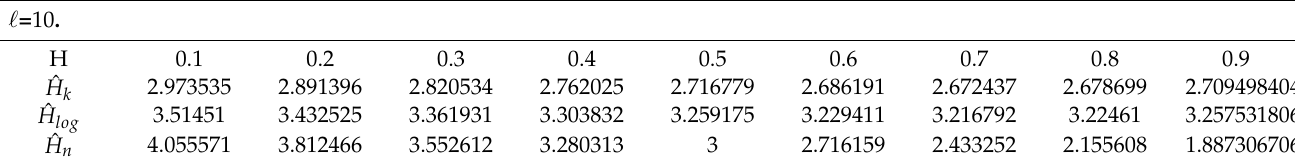
Figure 2. Comparison of asymptotic variance of H (cid:2924) with that of H (cid:2921) and H (cid:2922)(cid:2925)(cid:2917) .